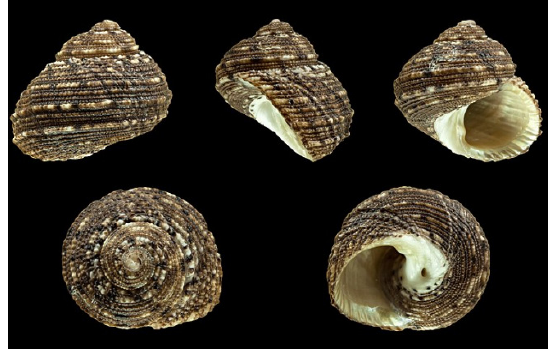
Figure 20. Images of the shell of Euchelus asper . © H. Zell (CC BY-SA 3.0); https: // commons.wikimedia. Figure 20 . Images of the shell of Euchelus asper . © H. Zell (CC BY-SA 3.0); https://commons. wikimedia.org.